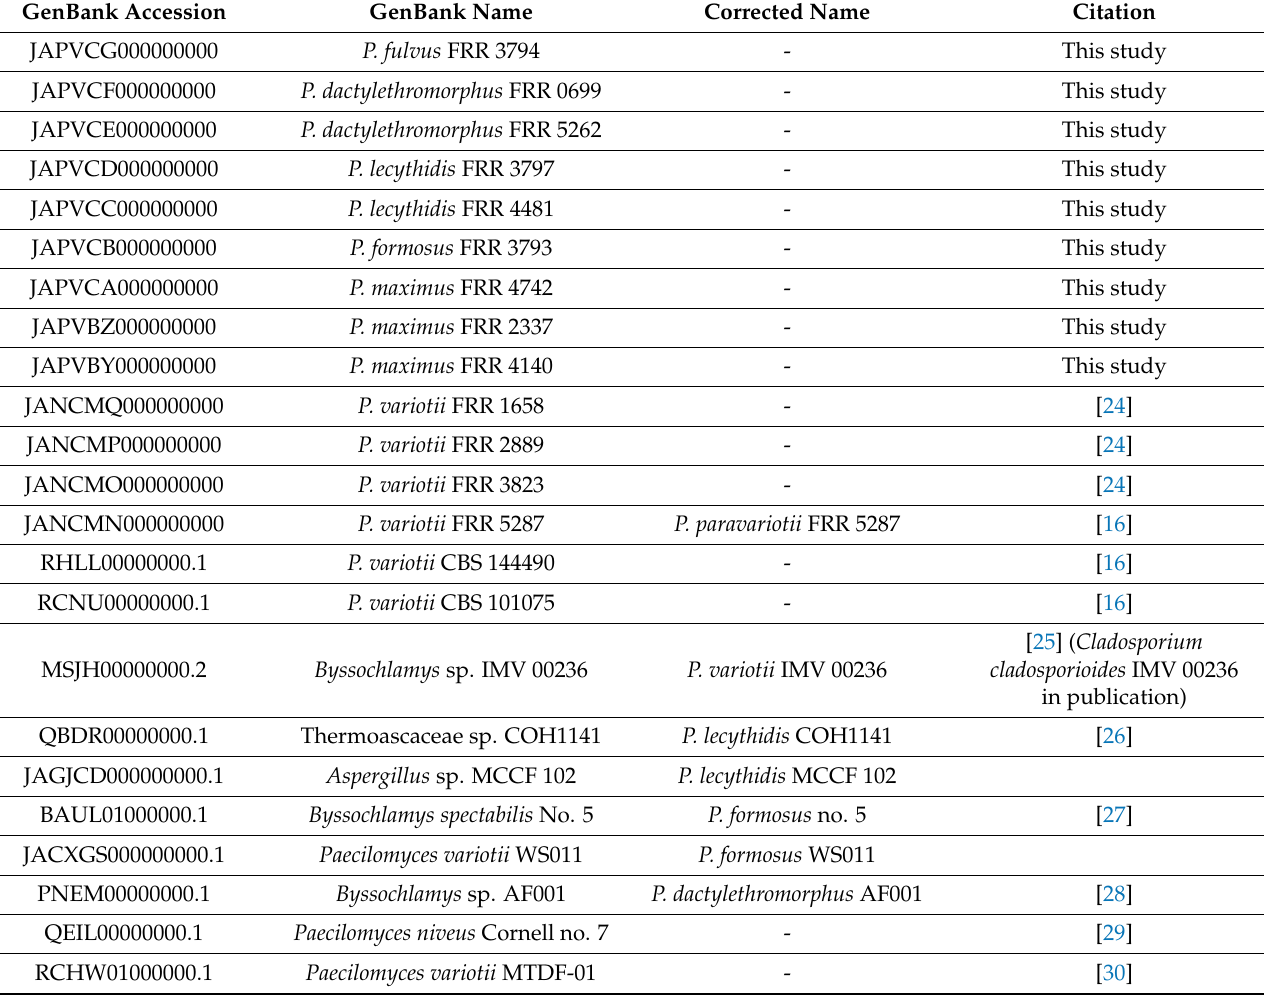
Table 1. Sequenced Paecilomyces